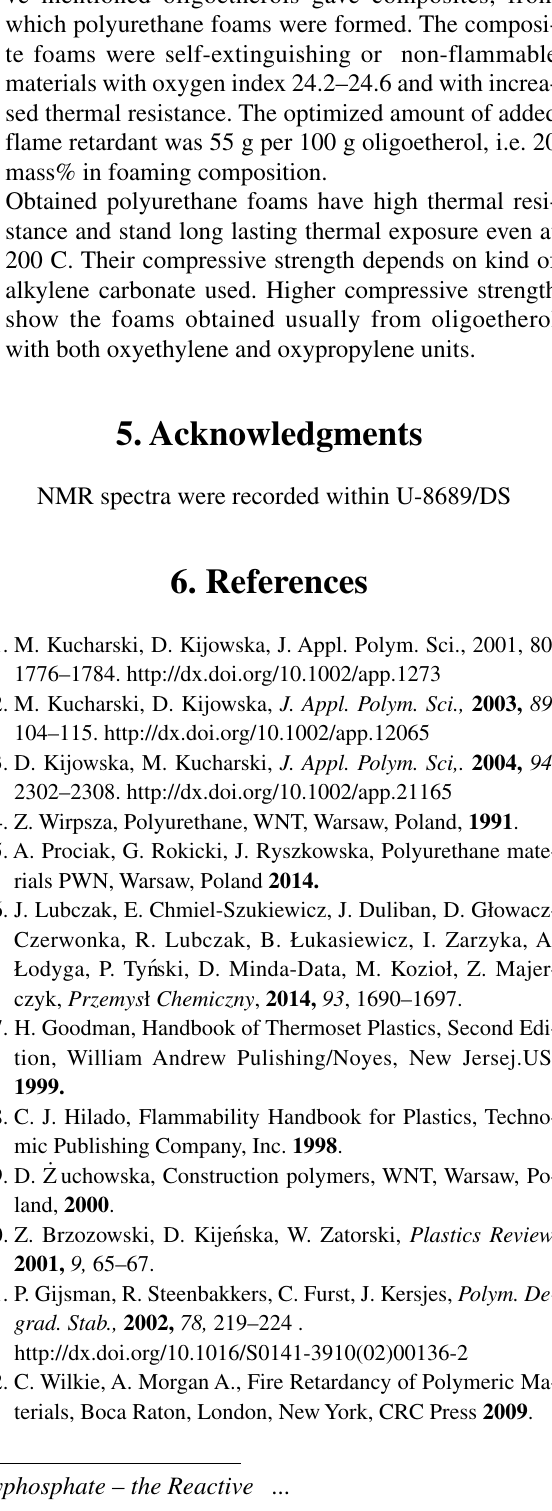
Introduction of MPP as additive flame retardant